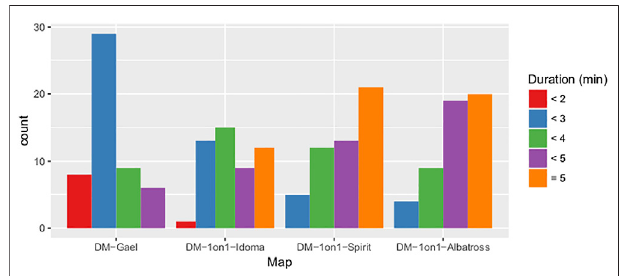
FIGURE 3 | Bar plot of the match duration (in minutes) depending on the